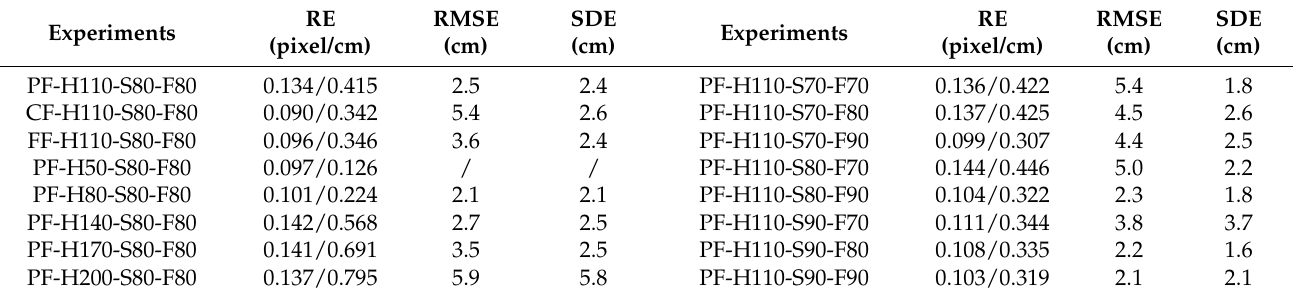
Table 3. Reprojection error, the root-mean-square error, and the standard deviation of error for each of UAV flight experiments with different photogrammetric